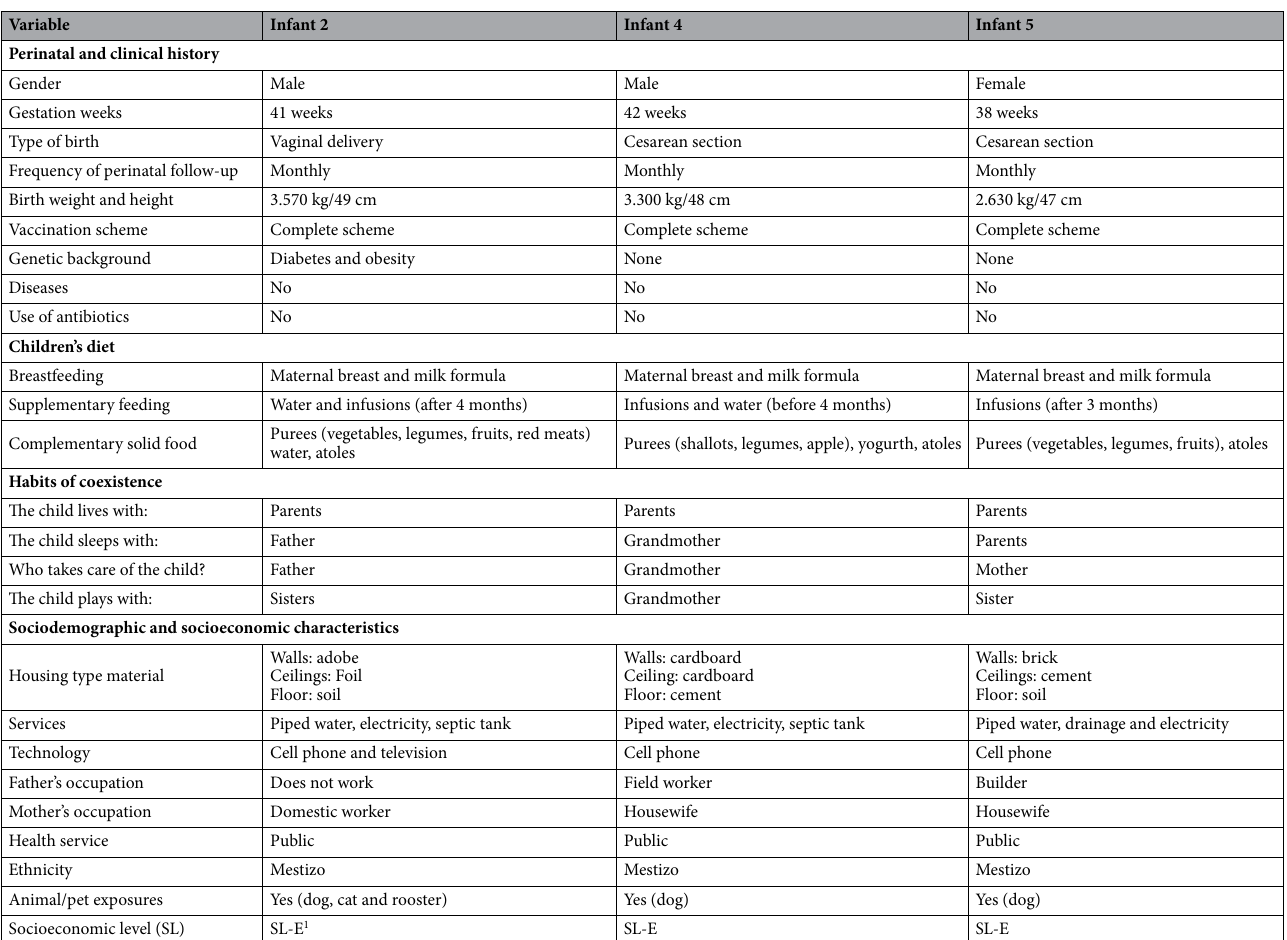
Table 1. General information of children. 1 SL-E: In this classification level, the majority (95%) of household